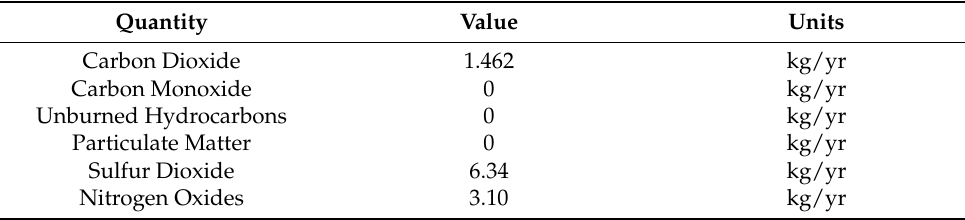
Figure 23. The course of energy purchased and sold to the grid. The last tab shows the emission measurements listed in Table 23. Table 23. Evaluation of CO 2